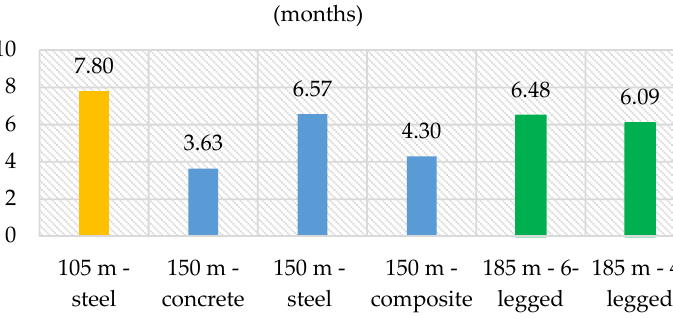
Figure 8. Comparison of hybrid 185 m towers with 105 m tower from [31] and 150 m towers from [45] Table 8. Comparison with the literature data.